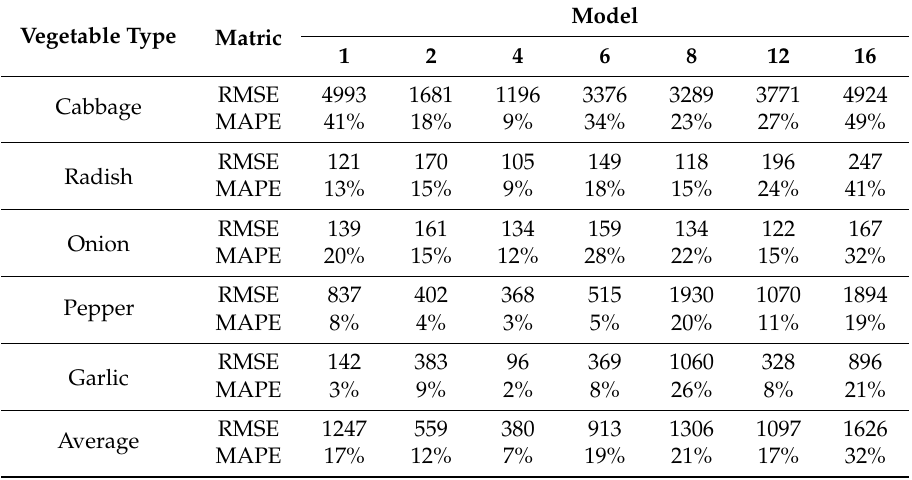
Table 5. Prediction accuracy measures of di ff erent